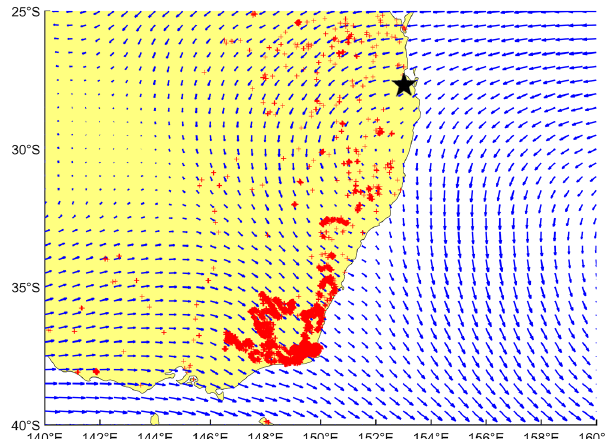
Figure 14. Monthly average background wind field based on wind information at pressure levels from 100 to 700hPa in January 2020. The red crosses present fire spots, and the black star represents the site